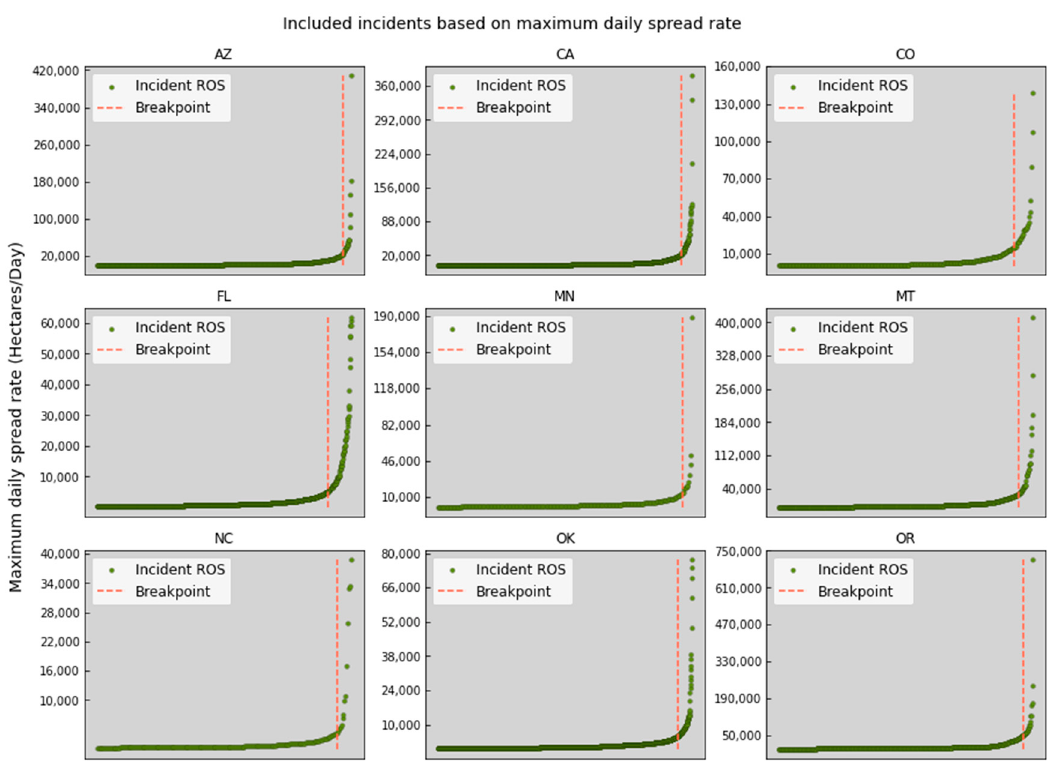
Figure 2. Daily maximum spread rate for incidents occurring in AZ, CA, CO, FL, MN, MT, NC, OK, and OR, 1999–2014, plotted in ascending order. ROS breakpoint is graphically demonstrated by the vertical dashed line. Incidents retrained for analysis are plotted to the right of the breakpoint while excluded incidents are plotted to the left.